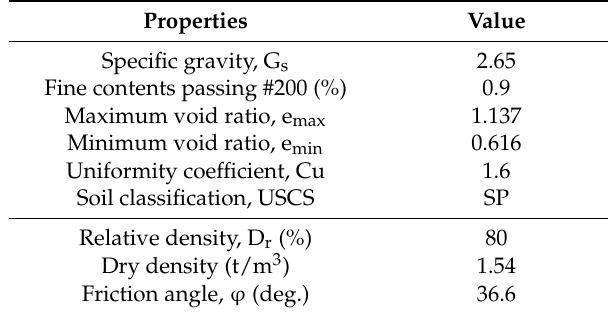
Table 2. Fundamental characteristics of soil modeling in centrifuge